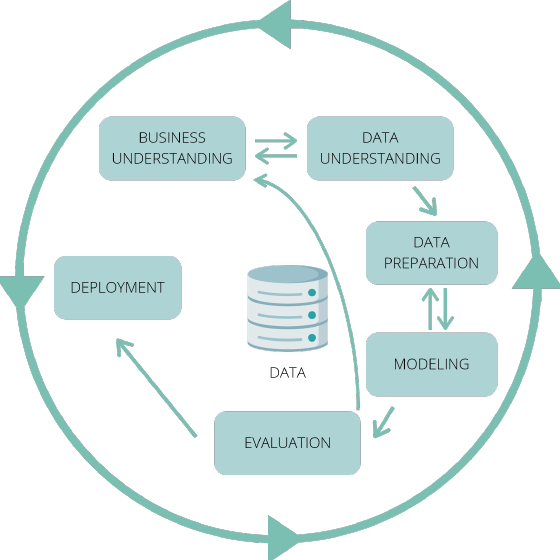
Figure 2. Stages of the CRISP-DM methodology for Data Mining (DM)